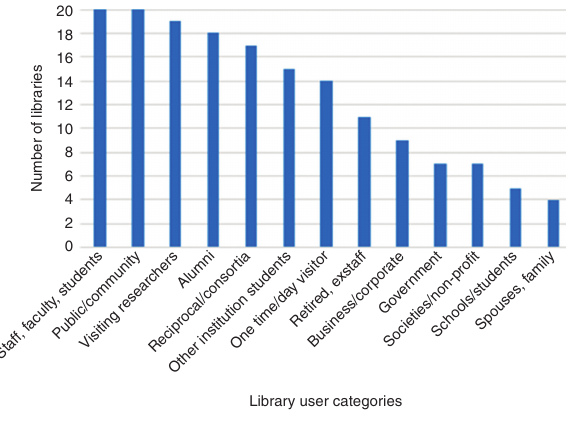
Fig. 1: Categories of users from library access policy